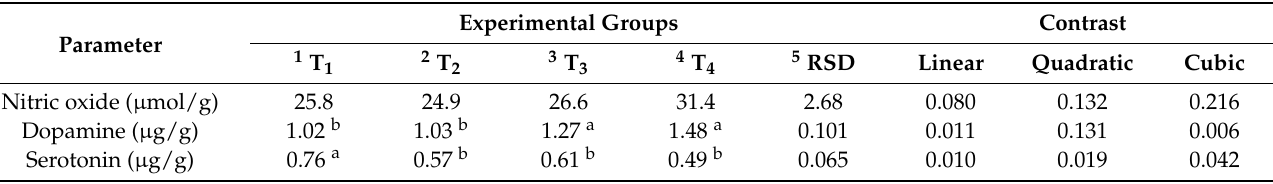
Table 4. Effect of dietary supplementation with GA on the levels of nitric oxide and neurotransmitters in the brain tissues of laying